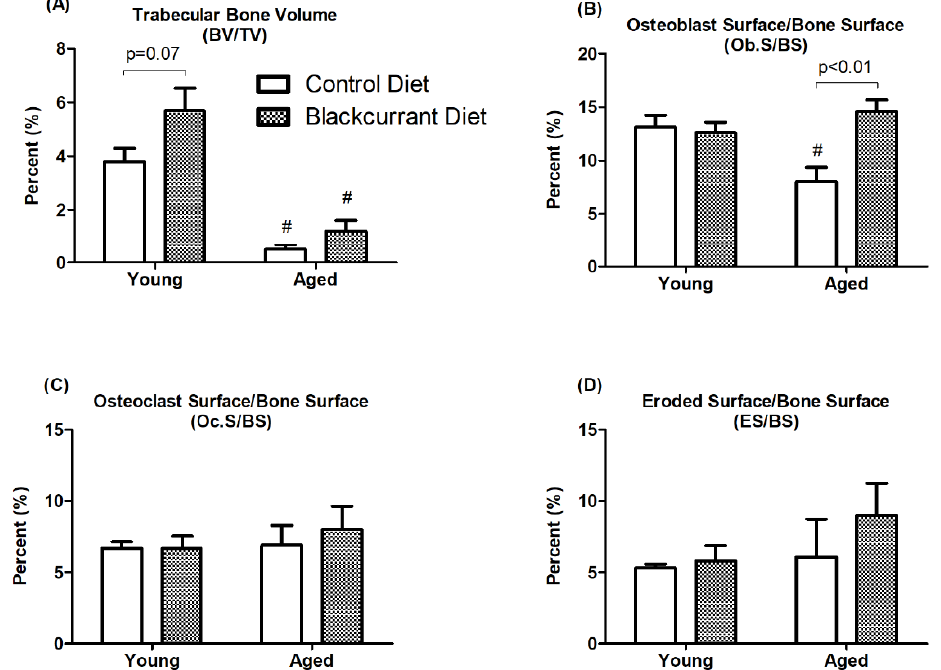
Figure 4. Histomorphometric analysis of femurs in young and aged mice consuming a control or blackcurrant (1% w / w ) diet for 4 months. Values are reported as mean ± SEM. Data were analyzed using an independent t-test. Young control ( n = 10), young BC ( n = 10), aged control ( n = 8), and aged BC ( n = 7). # Indicates significant difference by age in mice consuming the same diet.